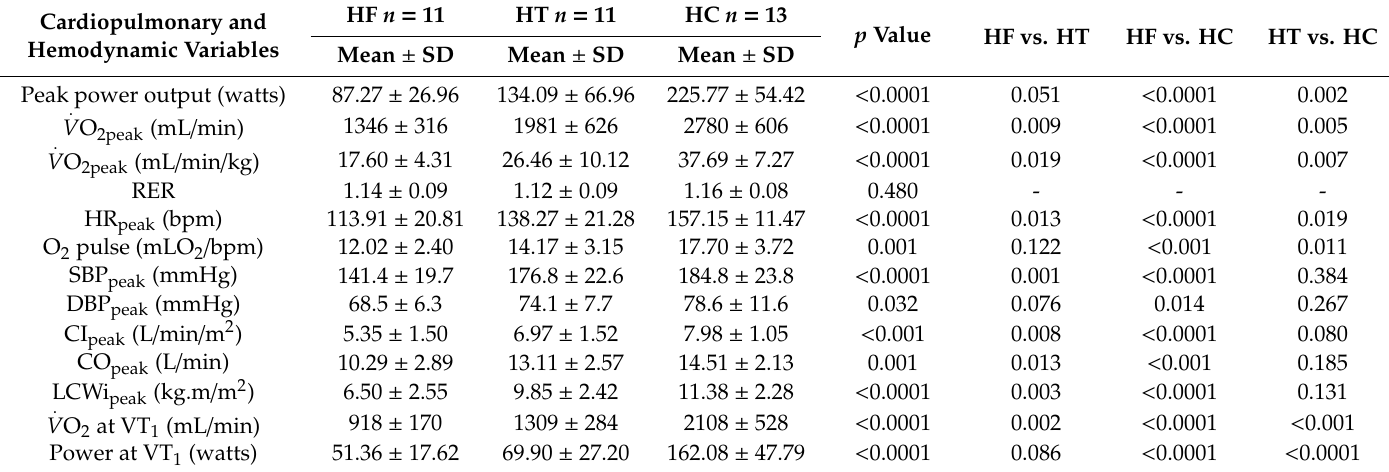
Table 2. Cardiopulmonary exercise test and cardiac hemodynamic variables in HC, HF and HT participants. Cardiopulmonary